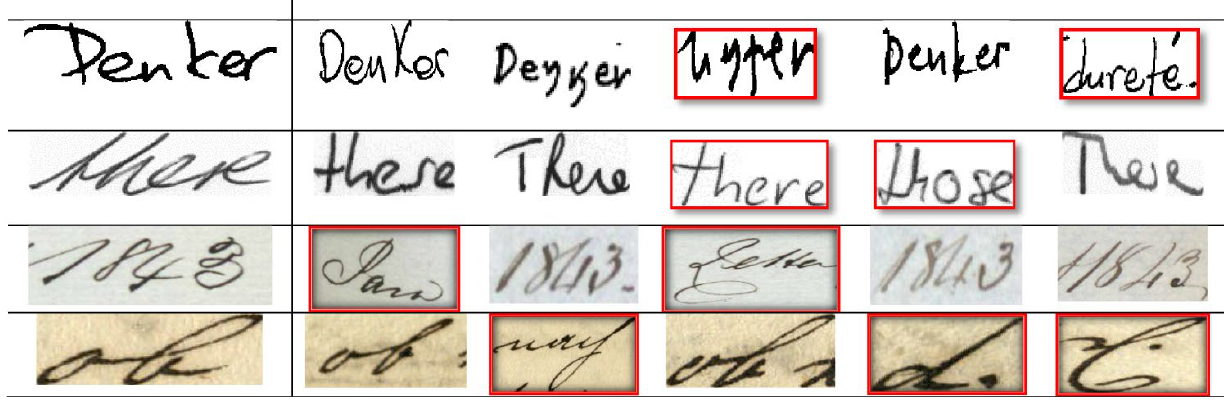
Table 4 Some choices of the arguments: ∅ 1 and ∅ 2 , and the corresponding effects on the final spotting result